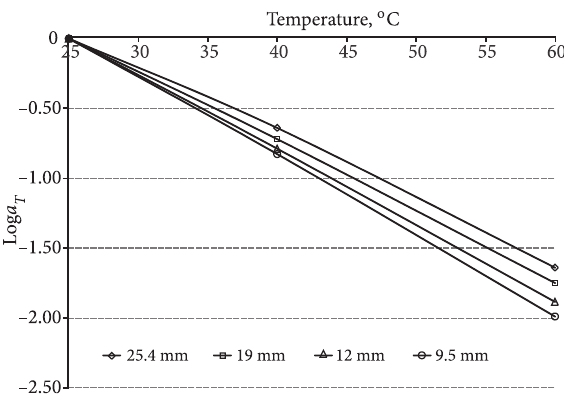
Fig. 7. Developed dynamic modulus master curves for SMA mixtures after shifting